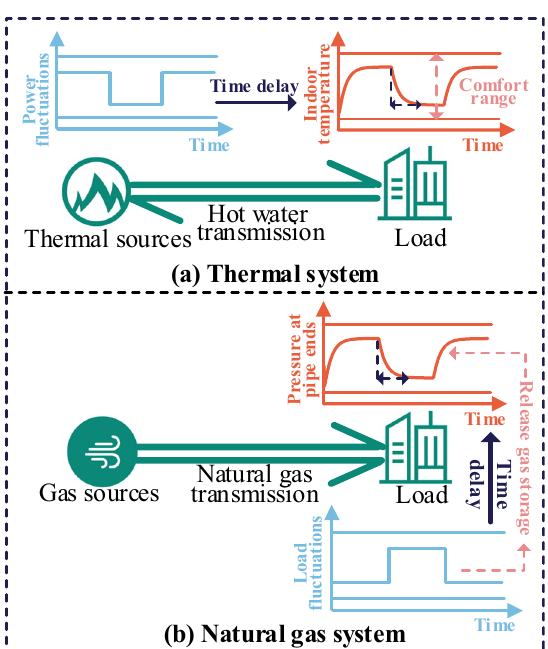
Fig. 1 Definition of gas inertia in contrast to thermal